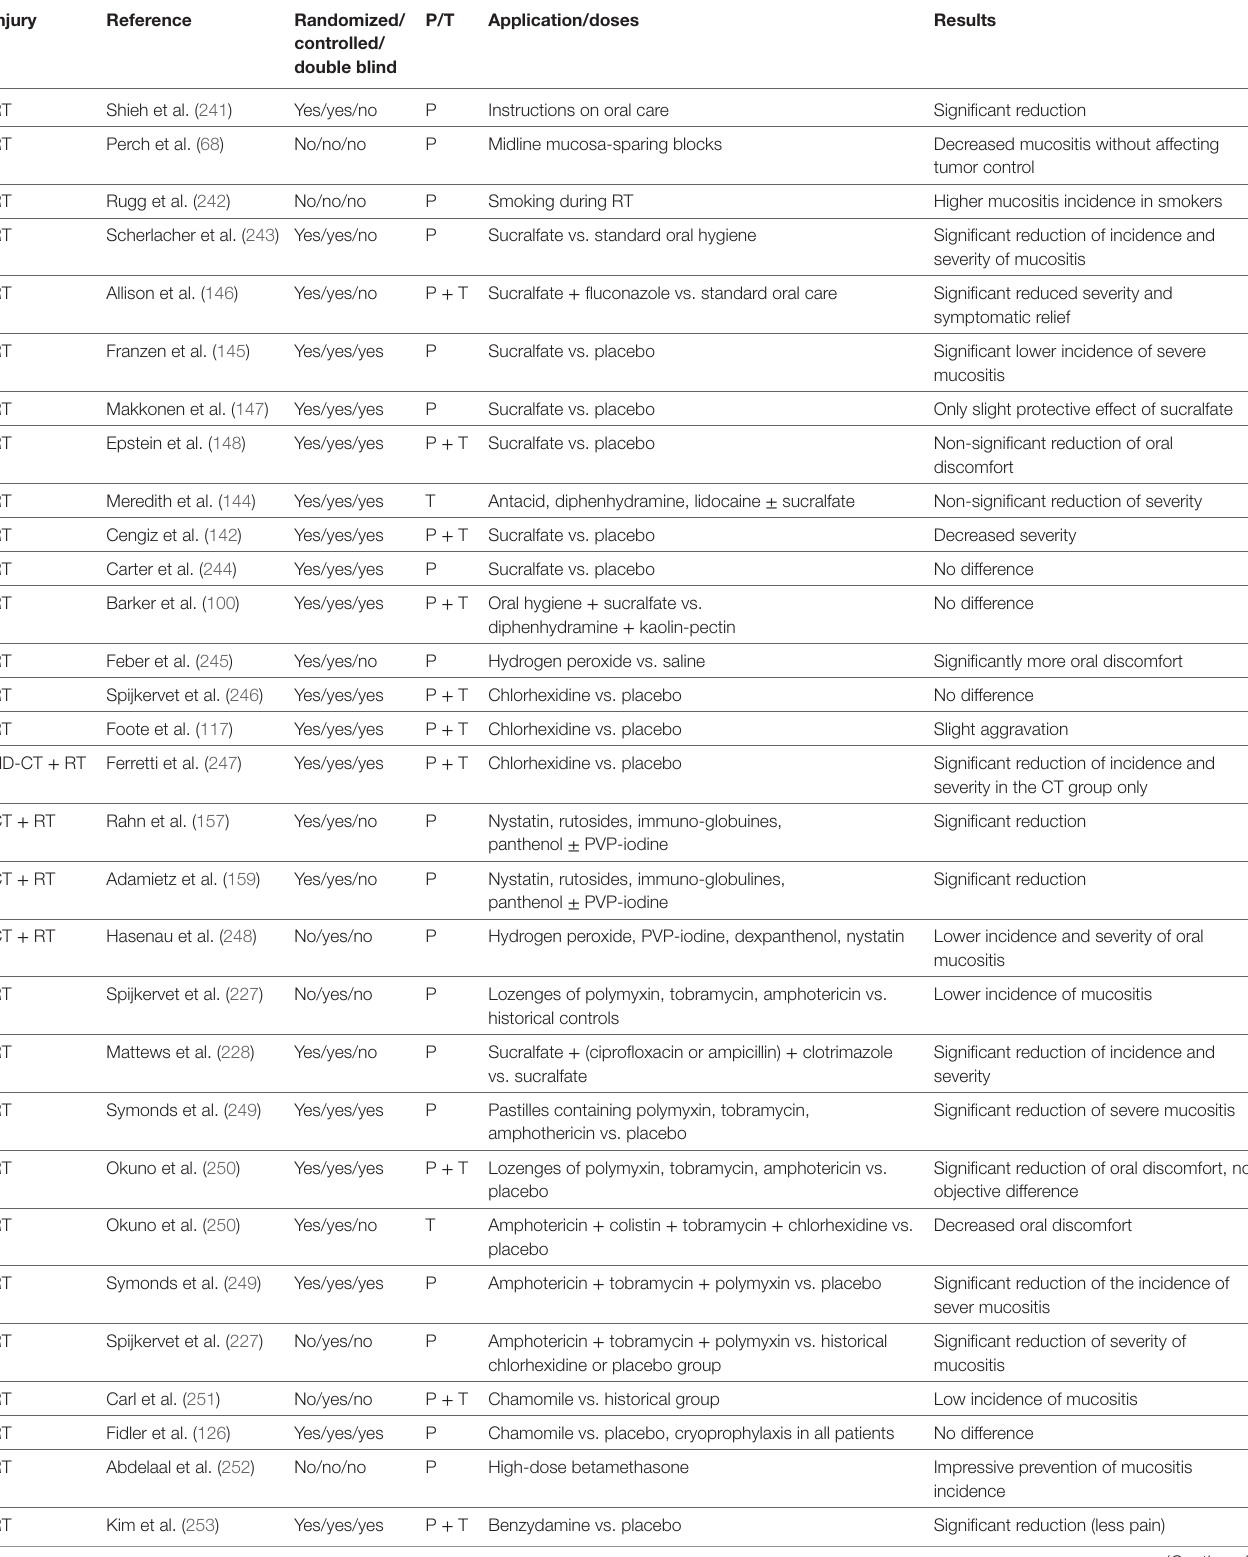
TAbLe 10 | Radiation-induced oral mucositis (RiOM) the clinical trials that have been done until 2001 (2) a